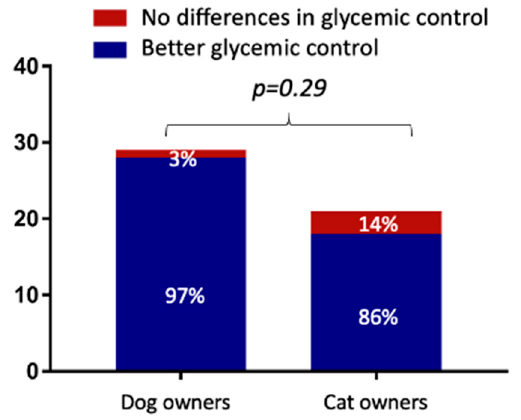
Figure 2. Comparison of dog and cat owners’ points of view regarding glycemic control of the flash glucose monitoring system (FGMS) when compared to blood glucose curves (BGCs).